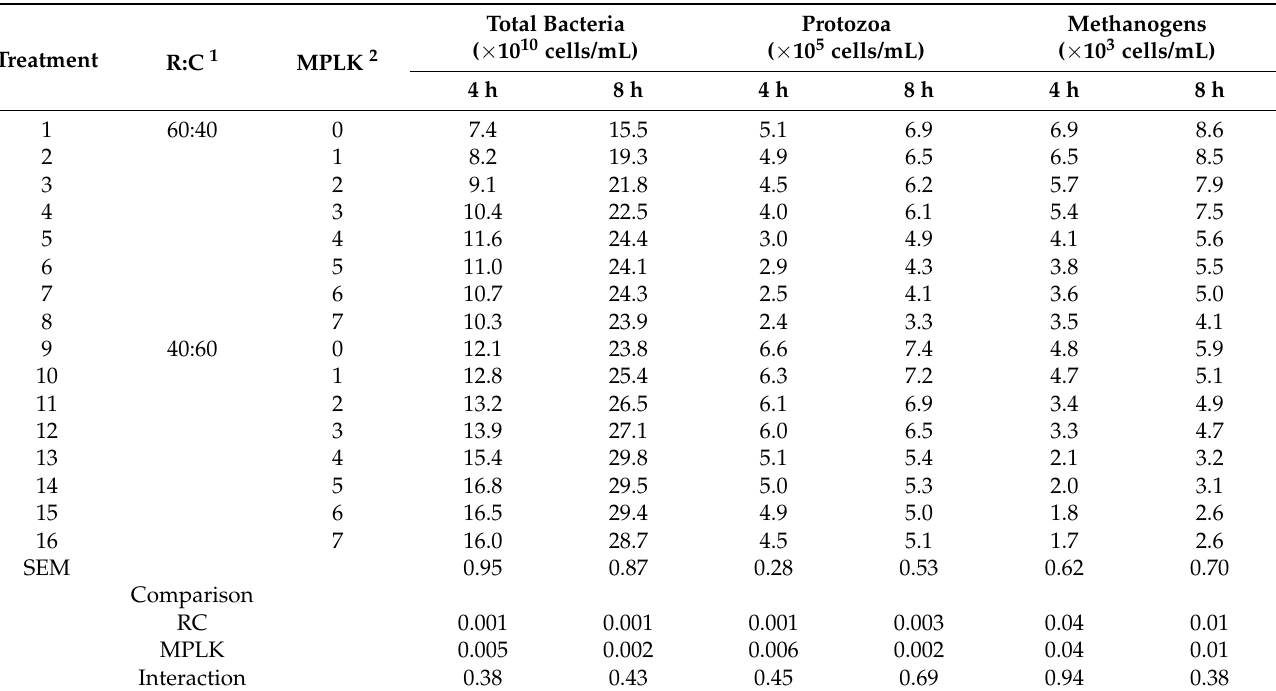
Table 5. The effect of roughage-to-concentrate (R:C) ratio with Mitragyna speciosa Korth leaves powder (MSLP) supplementation on microbial